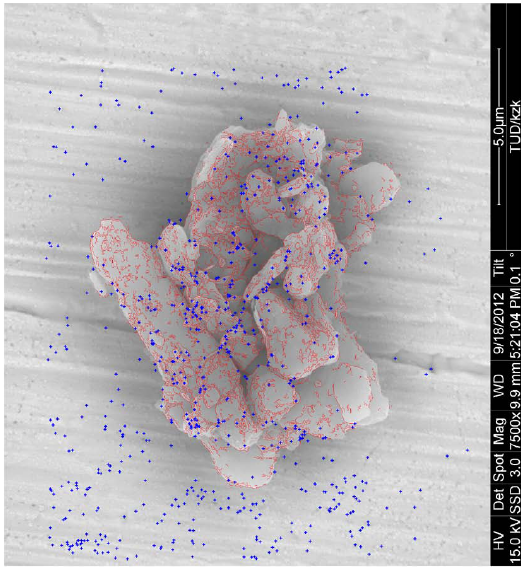
Fig. 4. Keypoints (blue crosses) and interest points (red dots) on the first SEM image of the Agg I particle.